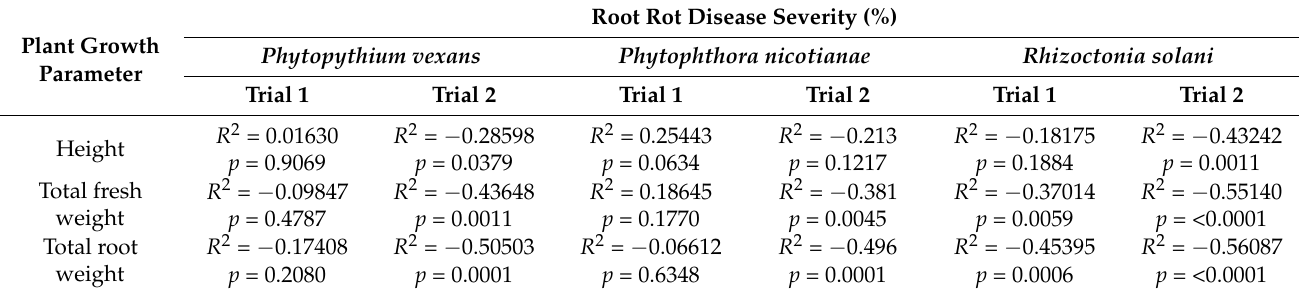
Table 7. Pearson correlation coefficient between the plant growth parameters and root rot severity caused by Phytophthora nicotianae , Phytopythium vexans and Rhizoctonia solani for all cover crops.